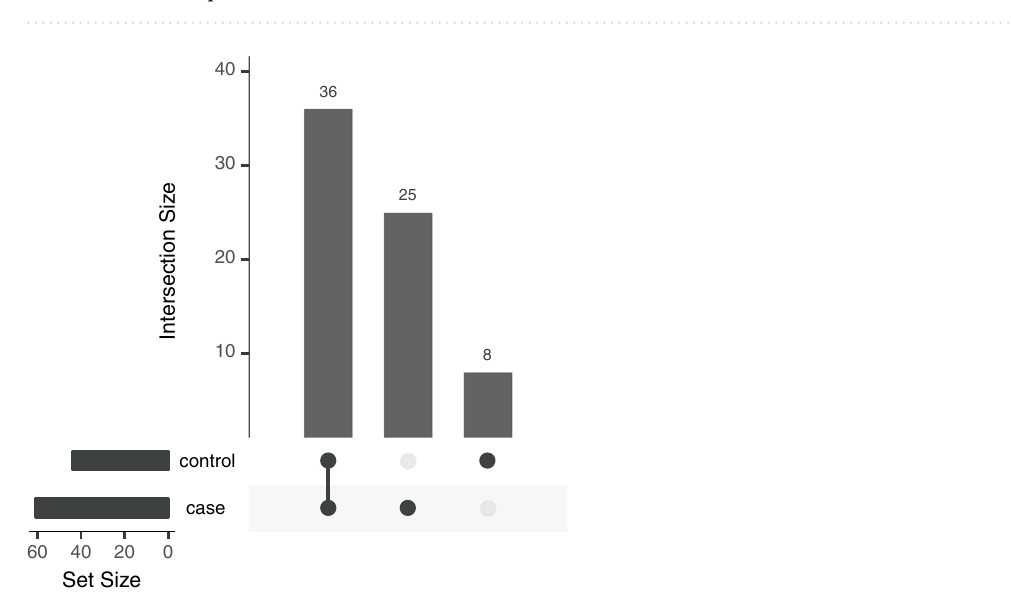
Table 2. Number of variants (N) and the genes in which most variants were found in each pair of tumor and internal control samples from the same individuals.